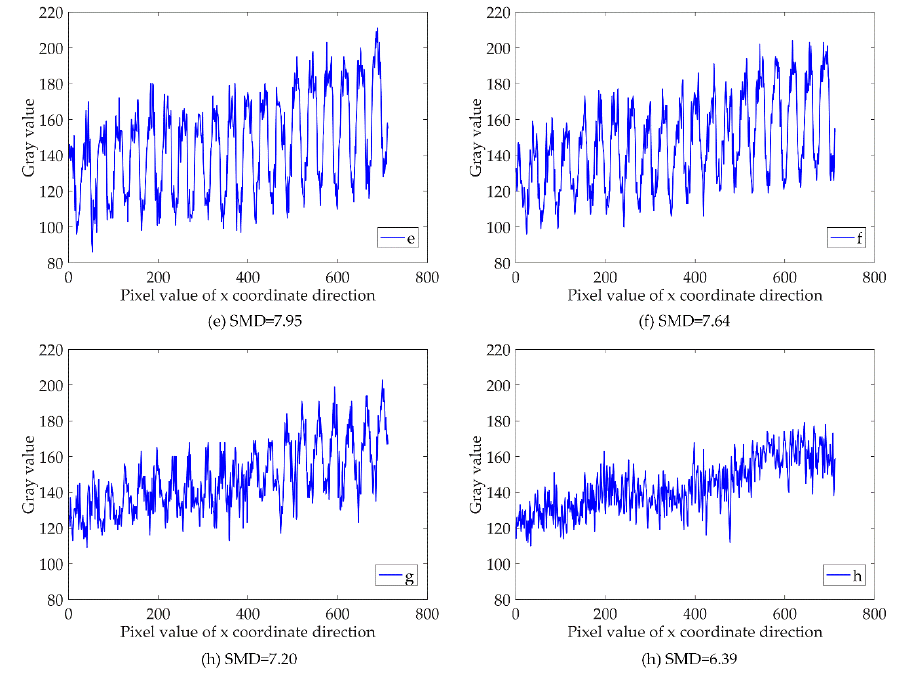
Figure 9. Gray value curves at different focal planes. Table 1. Adjacent Pixel Gray Variance and Normalization.